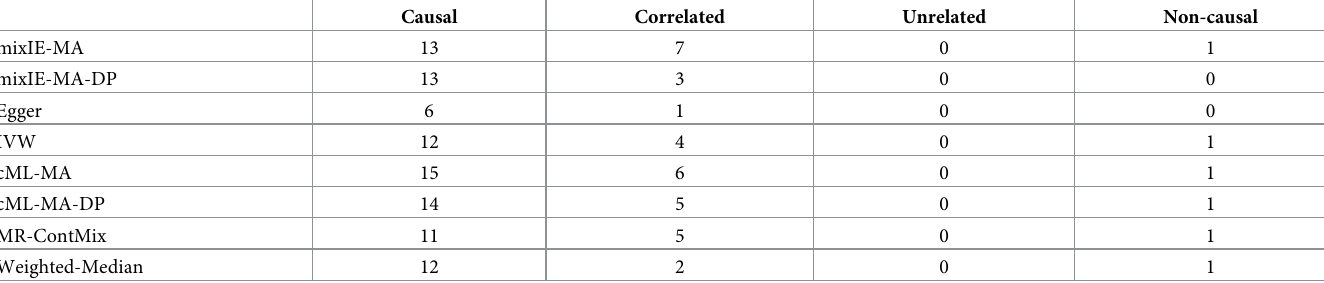
Table 2. Numbers of significant pairs among 48 risk factor-disease pairs at the significance cutoff of p-value <